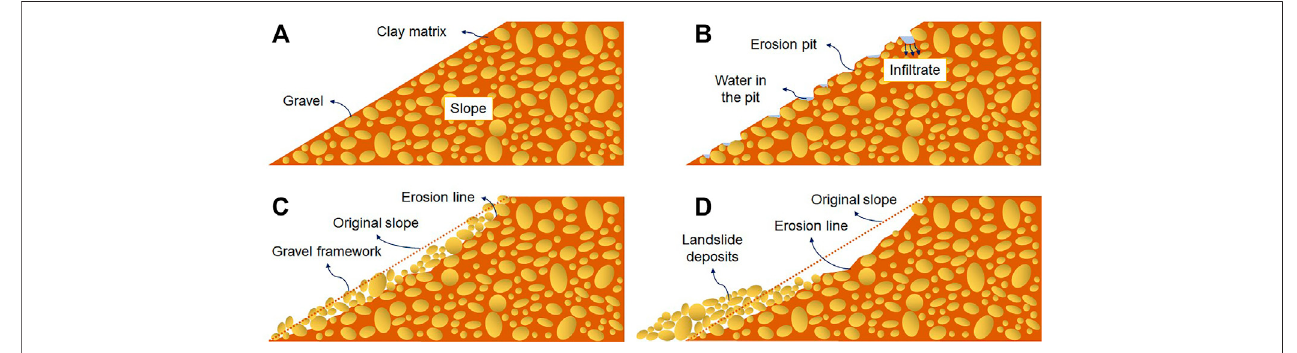
FIGURE 13 | Simpli fi ed diagram of slope erosion failure evolution law (gravel content 70%). (A) Initial slope (B) erosion pits (C) fi ne particle loss (D) slope